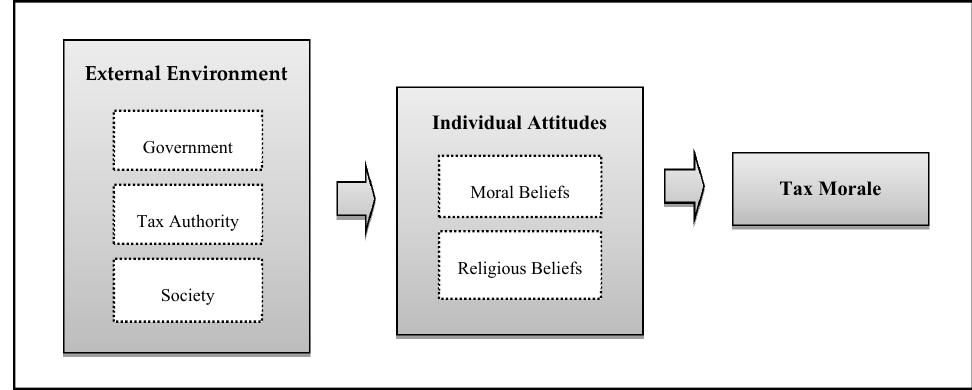
Figure 1. Main influences in the formation of tax morale (adapted from [14] (p.570)).